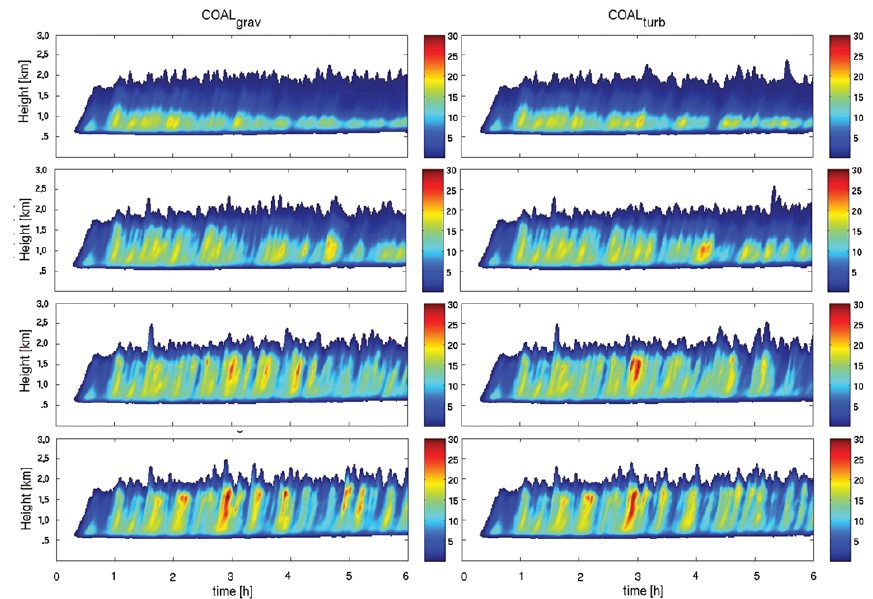
Fig. 9. Time evolution of the horizontally averaged cloud water mixing ratio. Left (right) column shows cases with the gravitational (turbulence-enhanced) kernel. Rows from top to bottom are for N 30, N 60, N 120, and N 240, respectively. Color scale depicts units of mgkg − 1 .